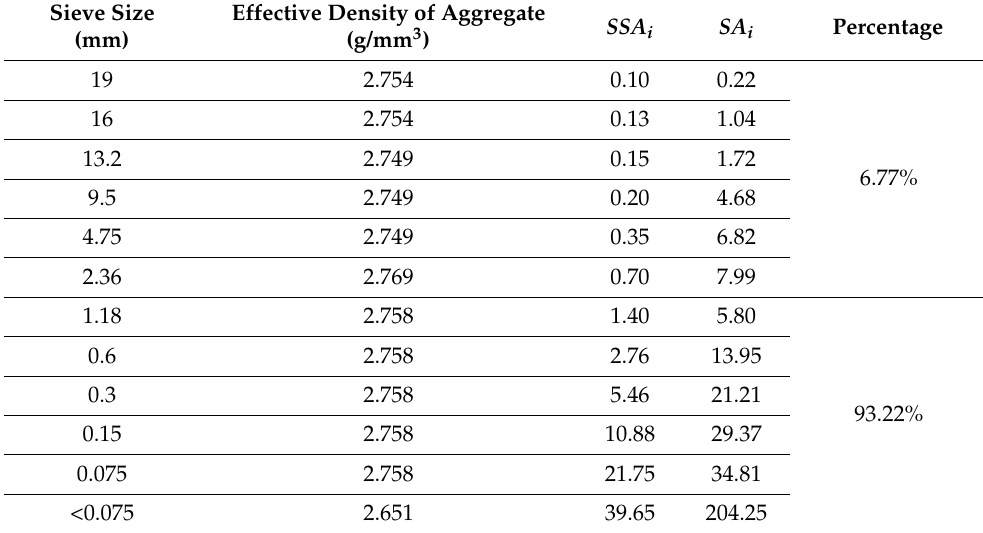
Passing of Asphalt Mixture